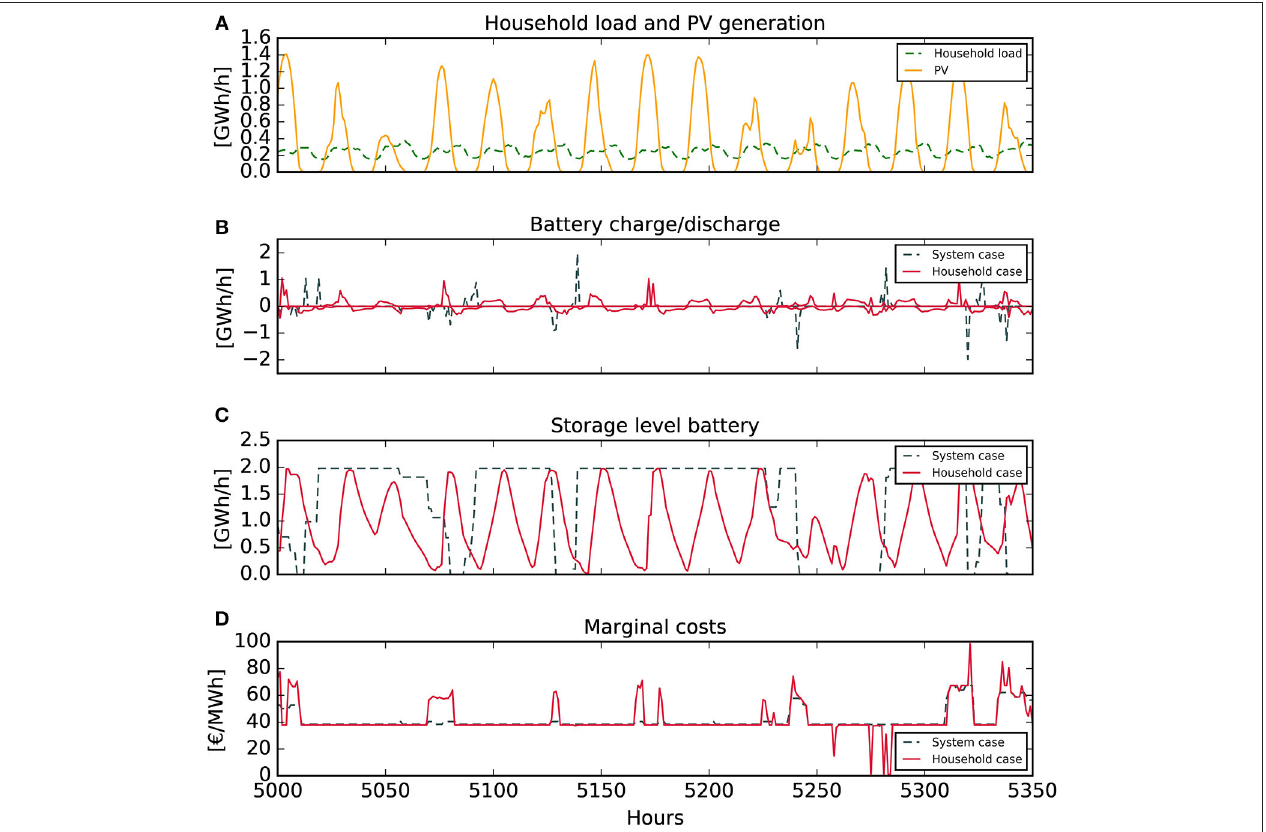
FIGURE 4 | (A) Household load and PV generation for two summer weeks in Year 2032, (B) the corresponding battery charge (on the positive y-axis) and discharge (negative y-axis) patterns, (C) the amount of electricity stored in the batteries, and (D) the marginal costs on an hourly resolution for 2 summer weeks, all as obtained from the modeling comparing the System and the Household cases in region SE1 for the Green Policy